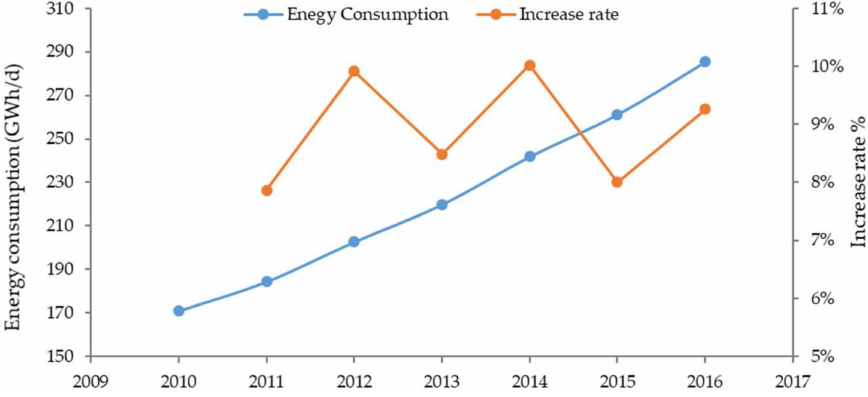
Figure 2. Water desalination energy consumption (electricity) from 2010 to